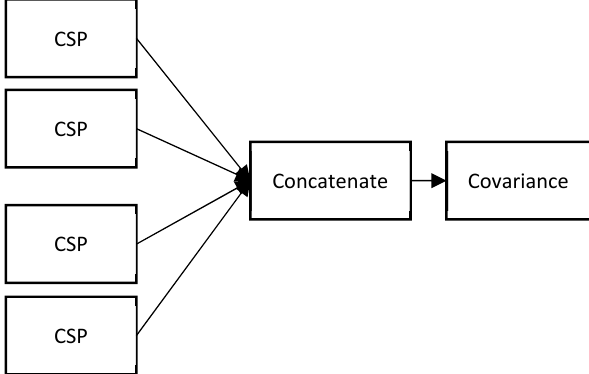
Figure 2. Graphical representation of the process of concatenation.